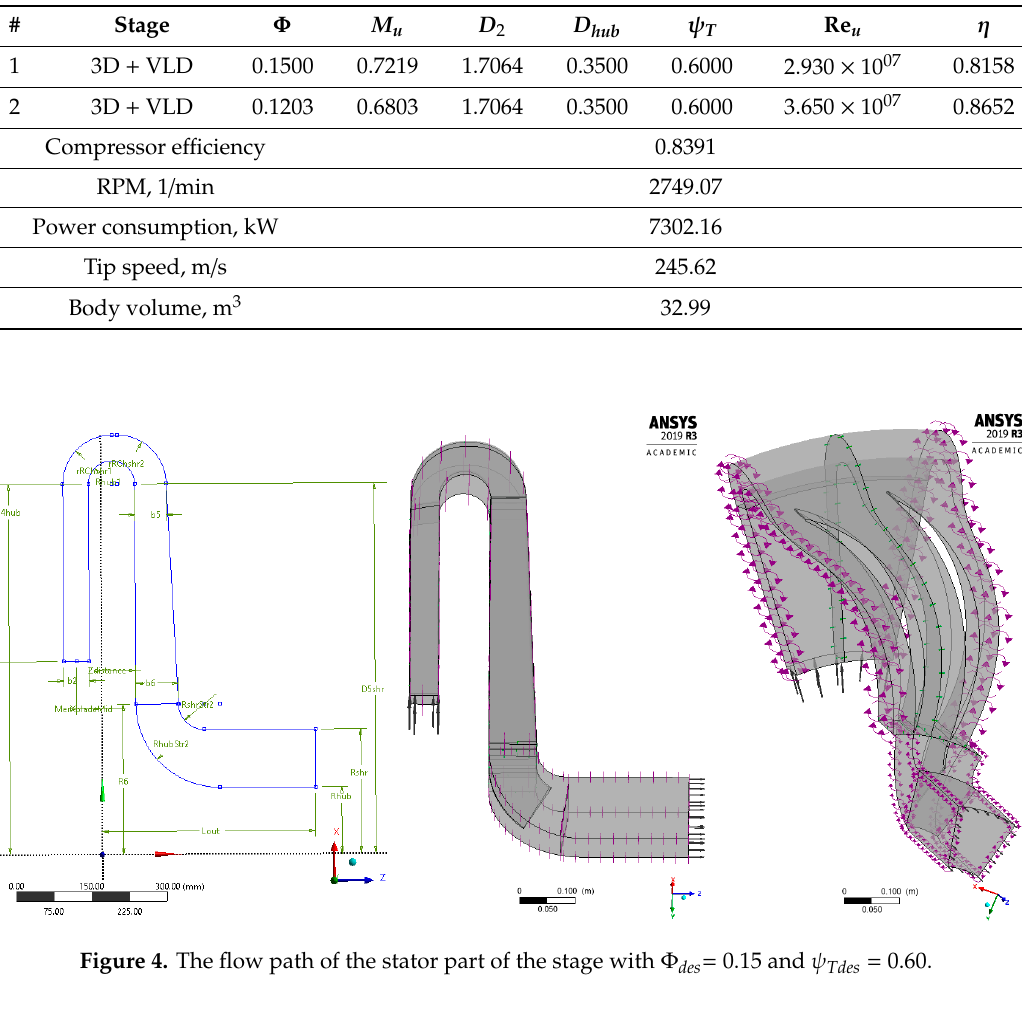
Table 2. Dimensions of the return channels of the stages with Φ des = 0.15 and ψ T des = 0.45, 0.60 and 0.70 (preliminary